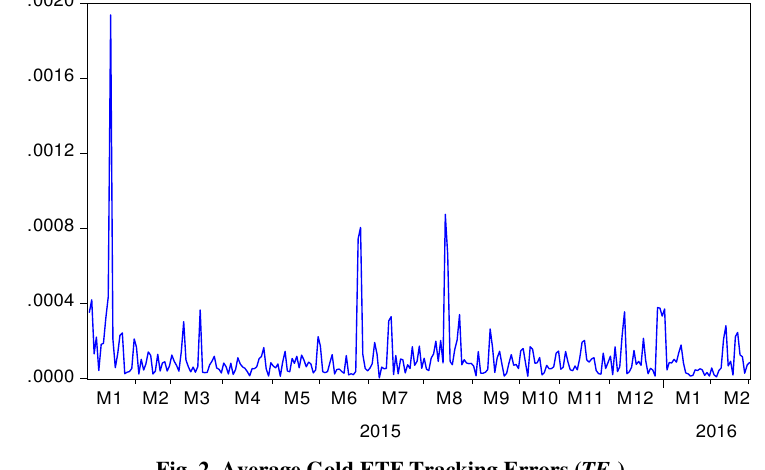
Fig. 2. Average Gold ETF Tracking Errors ( TE 1 ) Table 2. Tracking errors of gold ETFs for the three samples